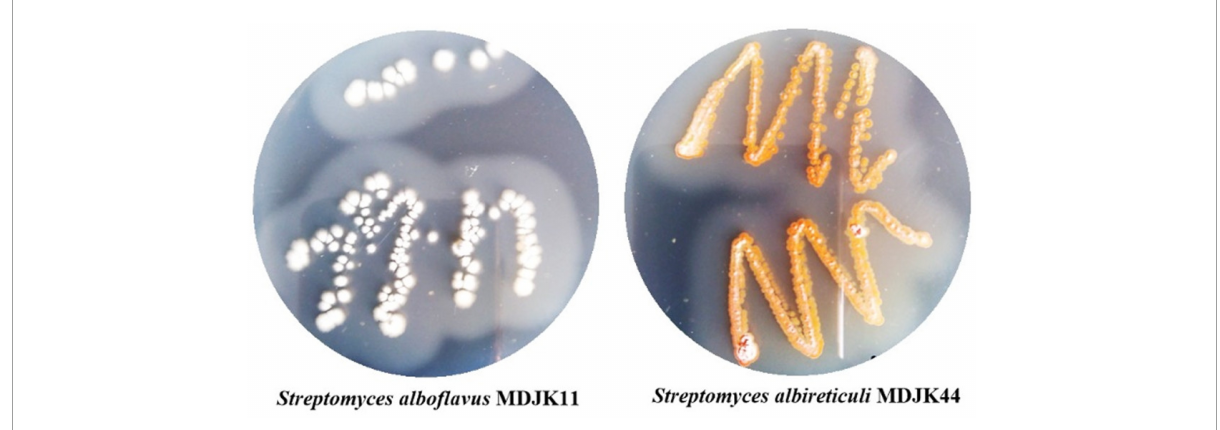
FIGURE1 Morphological characteristics of Streptomyces alboflavus MDJK11 and Streptomyces albireticuli